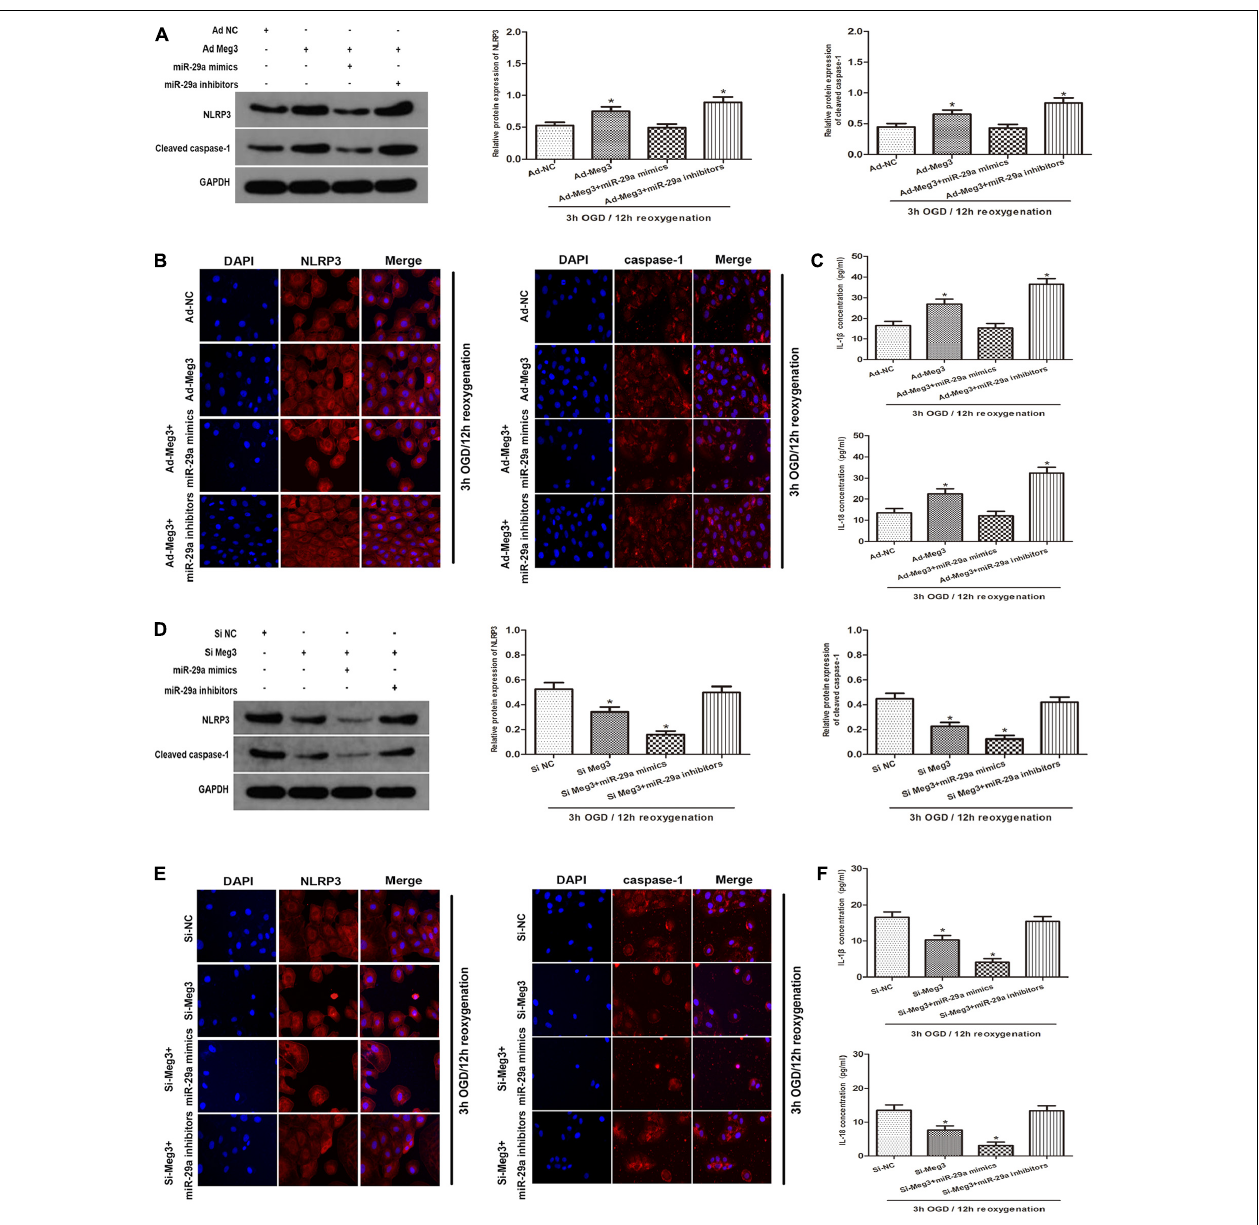
FIGURE 5 | MEG3 Regulates OGD/R-Induced Pyroptosis and Inflammation. (A) MEG3 regulates OGD/R-induced pyroptosis and inflammation. NLRP3 and cleaved caspase-1 protein expression in cells cotransfected with ad-MEG3 and miR-29a mimic or miR-29a inhibitor under 3 h/12 h OGD/R treatment. (B) Expression of NLRP3 and caspase-1 was measure by immunofluorescence in GC-1 cells transfected with ad-MEG3 and miR-29a mimic or miR-29a inhibitor under 3 h/12 h OGD/R treatment. (C) ELISA analysis was executed to measure the expression of IL-1 β and IL-18 in GC-1 cells transfected with ad-MEG3 and miR-29a mimic or miR-29a inhibitor under 3 h/12 h OGD/R treatment. (D) NLRP3 and cleaved caspase-1 protein levels in cells cotransfected with si-MEG3 and miR-29a mimic or miR-29a inhibitor under 3 h/12 h OGD/R treatment. (E) Expression of NLRP3 and caspase-1 was measured by immunofluorescence in GC-1 cells transfected with si-MEG3 and miR-29a mimic or miR-29a inhibitor under 3 h/12 h OGD/R treatment. (F) Measure IL-1 β and IL-18 expression by ELISA analysis in cells transfected with si-MEG3 and miR-29a mimic or miR-29a inhibitor under 3 h/12 h OGD/R treatment. The data are presented as the mean ± S.E.M. n = 6. * p < 0.05 vs. control.